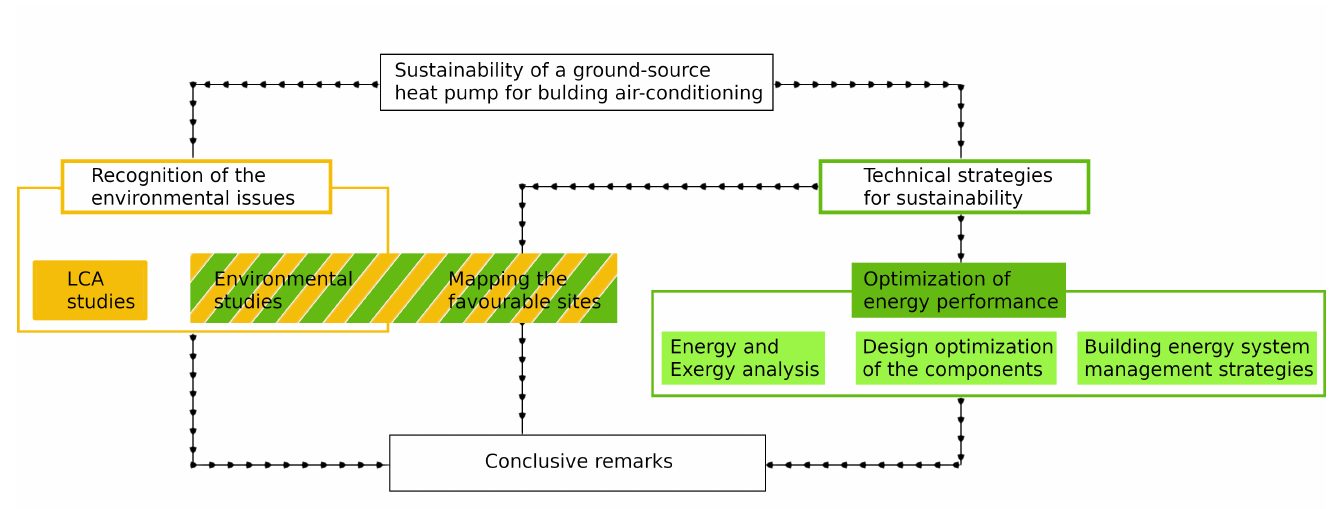
Figure 1. The overall structure of this review: environmental issues of geothermal heat pumps (yellow) and proposed solutions to enhance their sustainability